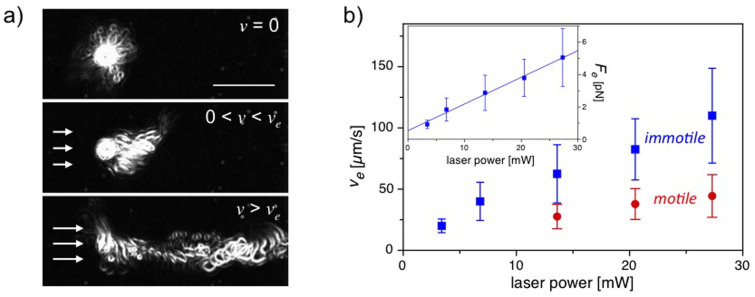
(a) Overlay of images of trapped trypanosomes in different flow conditions. The trypanosomes are dragged out of the optical trap at flow velocities of ve. Bar represents 20 μm. (b) Plot of ve versus the applied laser power for motile and immotile cells. Calibration curve of the stall forces Fe versus the applied laser power are shown in the inset.